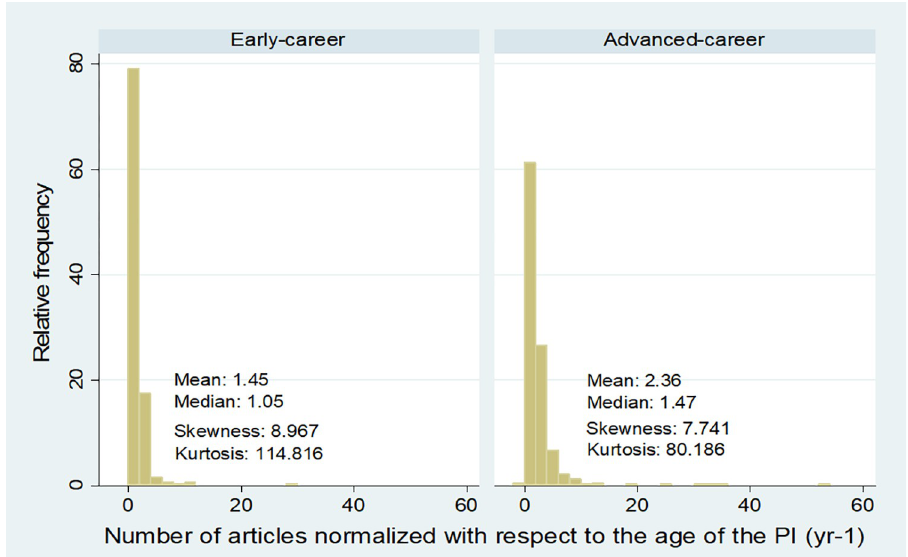
Fig 7. The distribution of the normalized number of peer-reviewed articles (1.1 articles) and distribution characteristics for different grant types through all grants awarded by the Estonian Research Council between 2013–2022. The article number was normalized with respect to the age of the PI (Eq. 1). The insets show the distributions after logarithmic transformation.